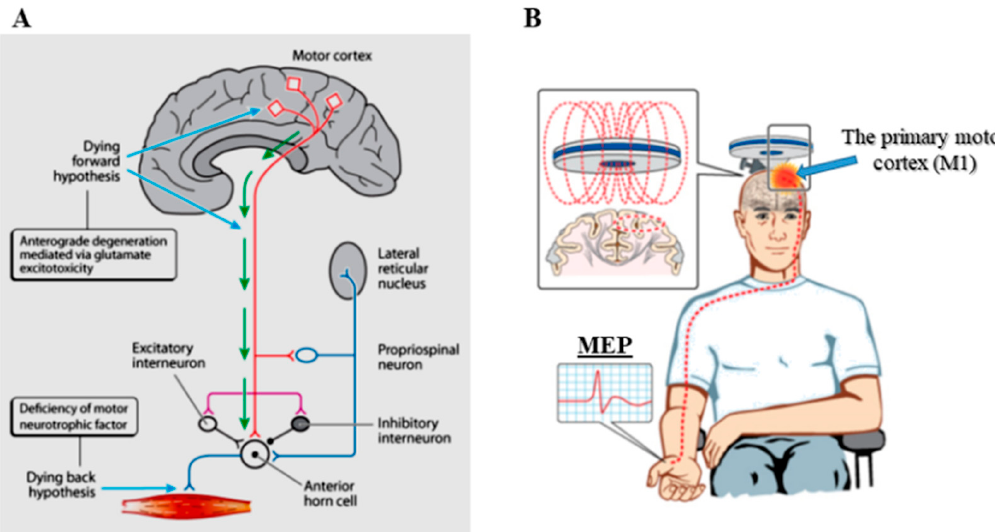
Figure 1. ( A ) The three theories for ALS onset are illustrated. The dying forward hypothesis proposes that ALS is primarily a disorder of the corticomotoneurons (red colour), which connect monosynaptically with the anterior horn cells, and mediate anterograde motor neuron degeneration via glutamate excitotoxicity. In contrast, the dying back hypothesis proposes that ALS begins within muscles or at the neuromuscular junction, with noxious factors transported retrogradely from the periphery to the axon cell body, where they exert toxic e ff ects. The independent degeneration hypothesis proposed that upper and lower motor neuron degeneration occurs independently. ( B ) Transcranial magnetic stimulation excites neurons in the underlying motor cortex, with motor evoked potentials (MEP) recorded over the contralateral muscle. It is a sensitive measure of cortical excitability.